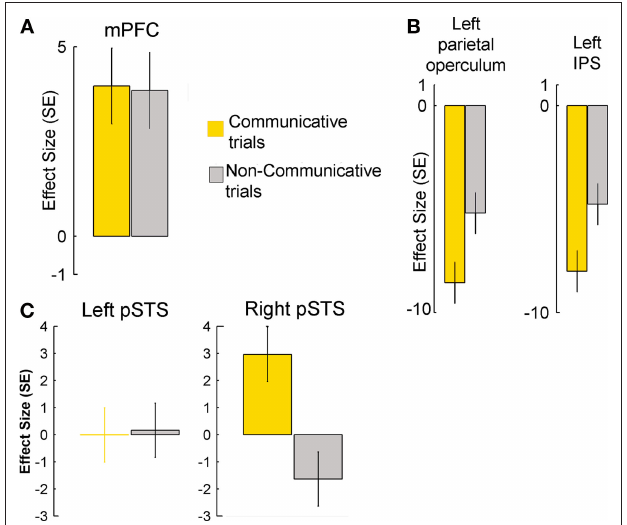
FIGURE 4 | Planning-related activity in cerebral regions of the sender’s brain during COMMUNICATIVE and NON - COMMUNICATIVE trials. (A) There was robust activity during both trial types in the mPFC (MNI coordinates: 4, 54, 18, p < 0.05 corrected for multiple comparisons), a region previously associated with conceptually-based accounts of human mind-reading abilities. (B) There were robust decreases in activity in the left parietal operculum (MNI coordinates: − 52, − 24, 44, p < 0.05, corrected for multiple comparisons) and intraparietal sulcus (MNI coordinates: − 38, − 34, 64, p < 0.05, corrected for multiple comparisons) regions previously associated with sensorimotor accounts of human mind-reading abilities. The decreases of metabolic activity, a sign of reduced neural activity, were signifi cantly stronger during the planning of communicative actions. (C) The plots show effect sizes for left and right pSTS (in standard error units) of cerebral activity from volumes of interest (VOIs – 10 mm centered on published stereotactical coordinates for the pSTS and adjusted for effects of interest) evoked in the sender during the planning epochs of COMMUNICATIVE and NON - COMMUNICATIVE trials.